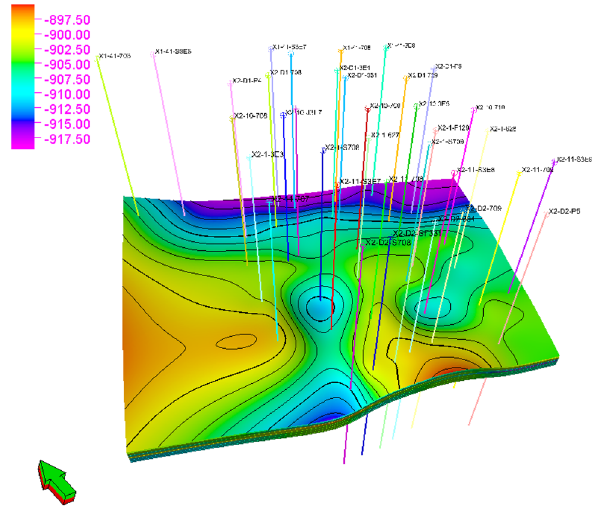
Fig. 4 The structural model of the study